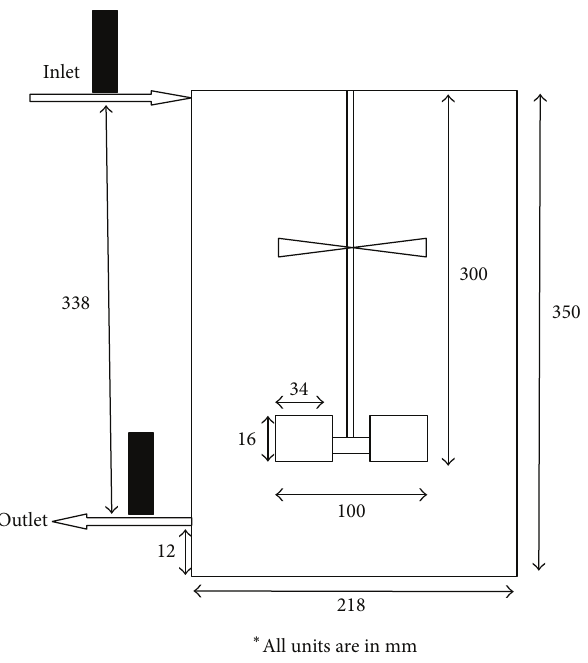
Figure 2: Schematic diagram of Type B